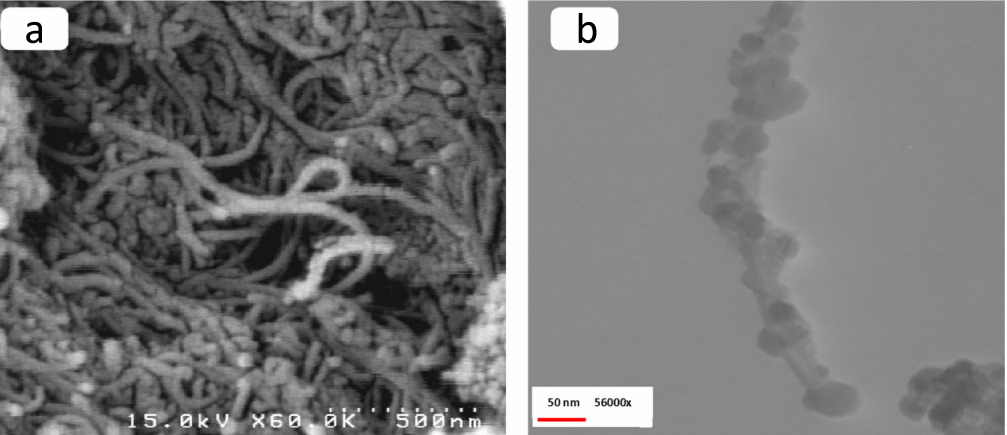
Figure 19. ( a ) SEM image of a nanohybrid structure with a resolution of 500 nm; and ( b ) Transmission electron microscope (TEM) image of the nanohybrid structure. The carbon nanotube structure as well as the silica particles are clearly distinguished Figure reproduced from Ref.